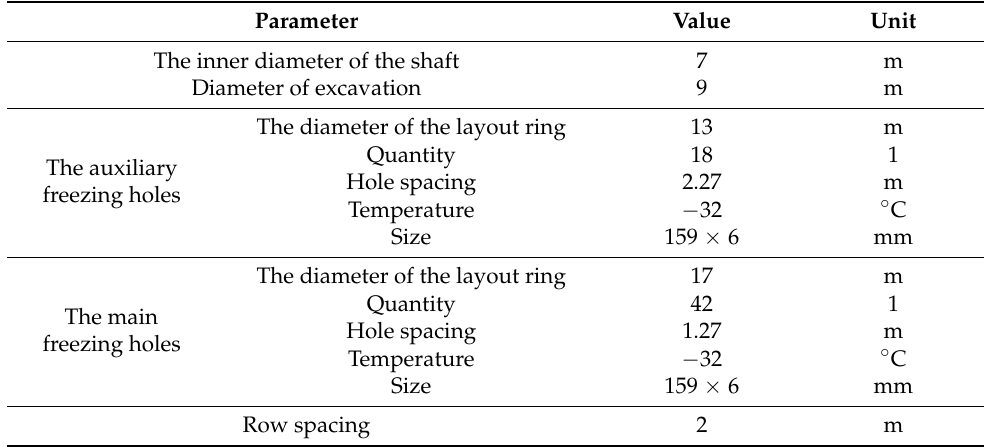
Table 7. Freezing parameters of the wind well in the Zhangji Mine.